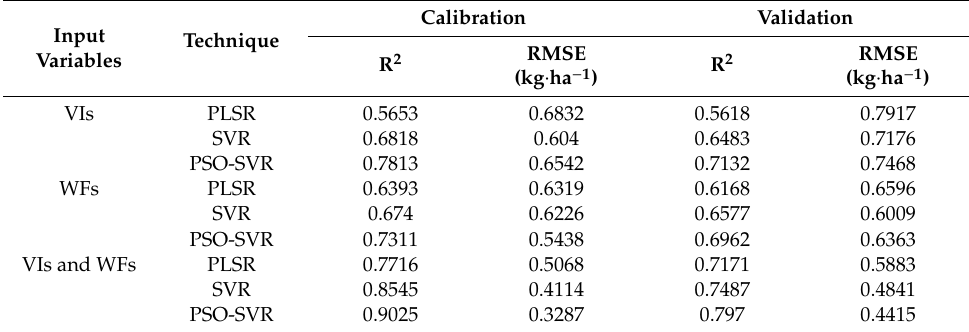
Table 2. Estimation model for the aboveground nitrogen content of wheat based on di ff erent variables with three techniques.